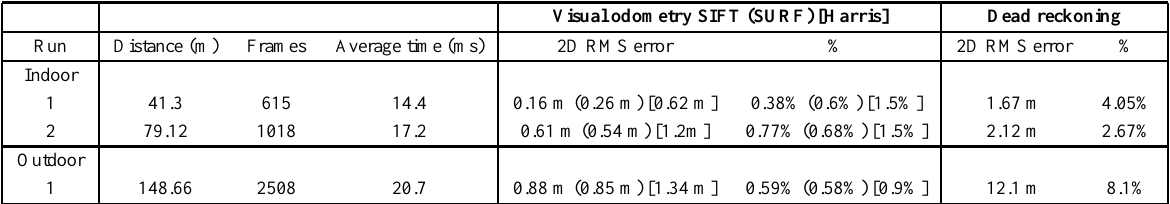
Evaluation of the algorithm for real experiments in indoor and outdoor environments (average values).